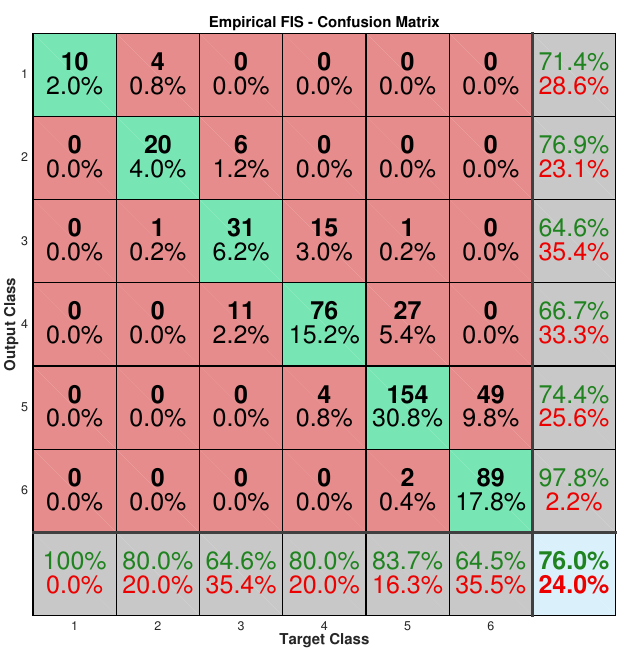
Figure 7. Confusion Matrix of the Empirical Fuzzy Inference System (FIS)